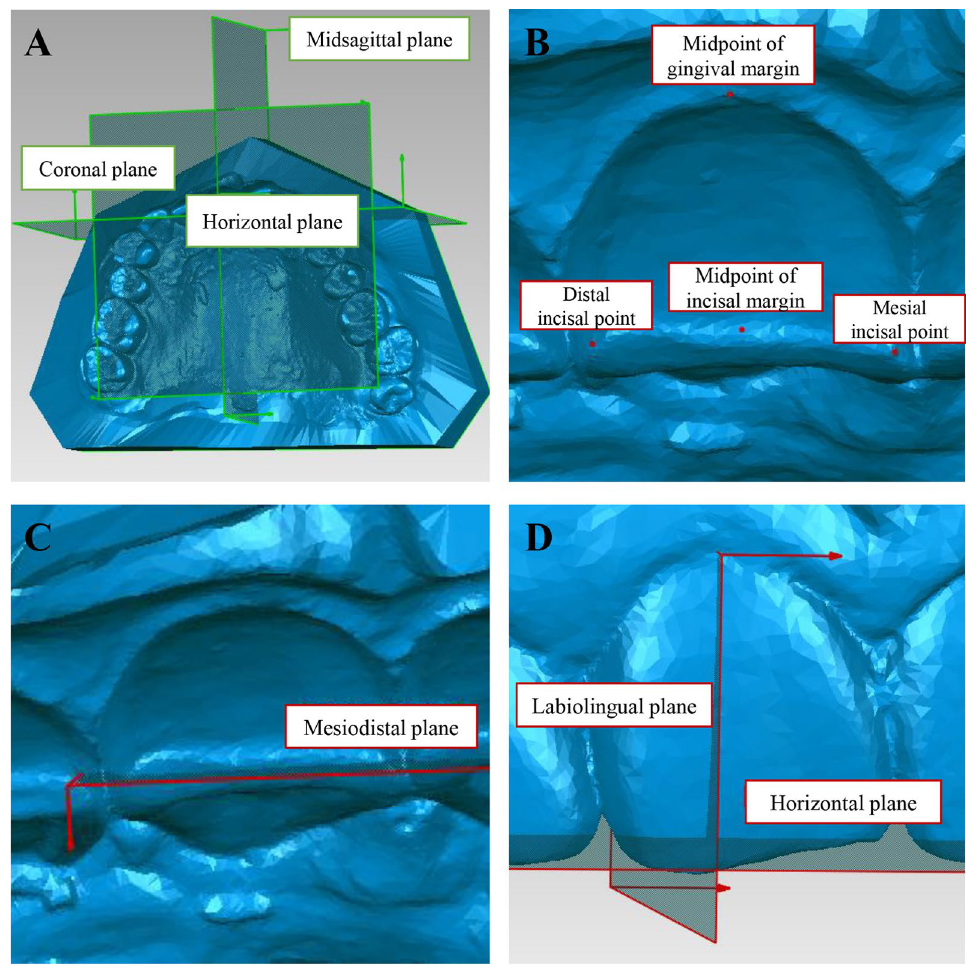
Fig. 3 Construction of reference planes. A Three reference planes constructed on T0. B Point identification on upper incisors. C Mesiodistal plane constructed on upper incisors. D Labiolingual plane constructed on upper incisors